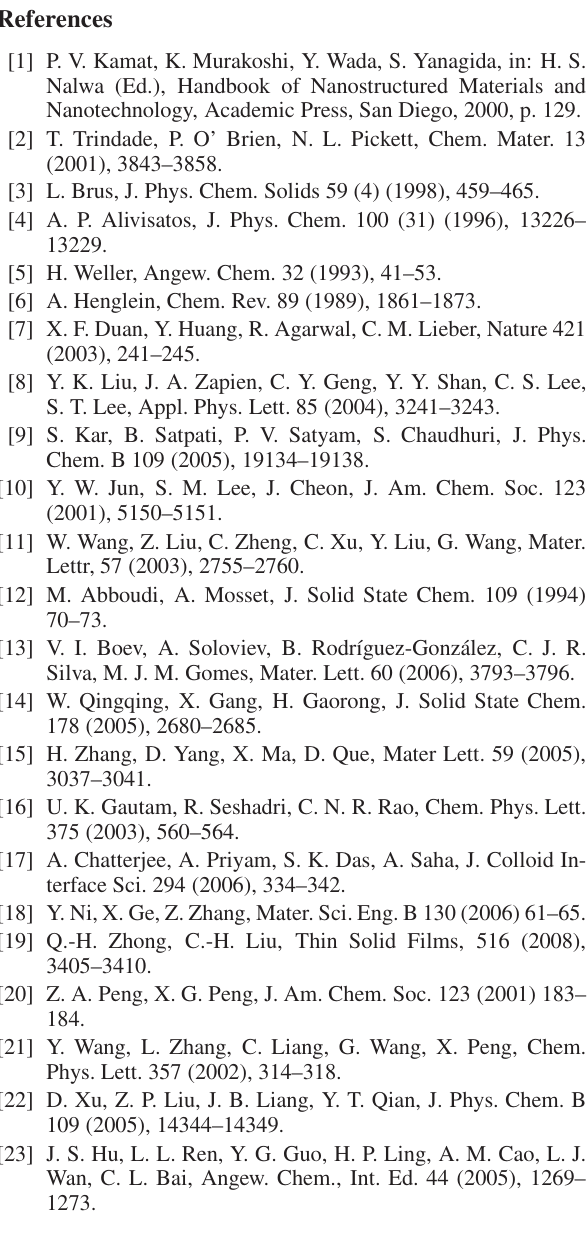
Figure 4. FT-IR spectrum of the CdS nanoparticles synthe- sized via decomposition of precursor.